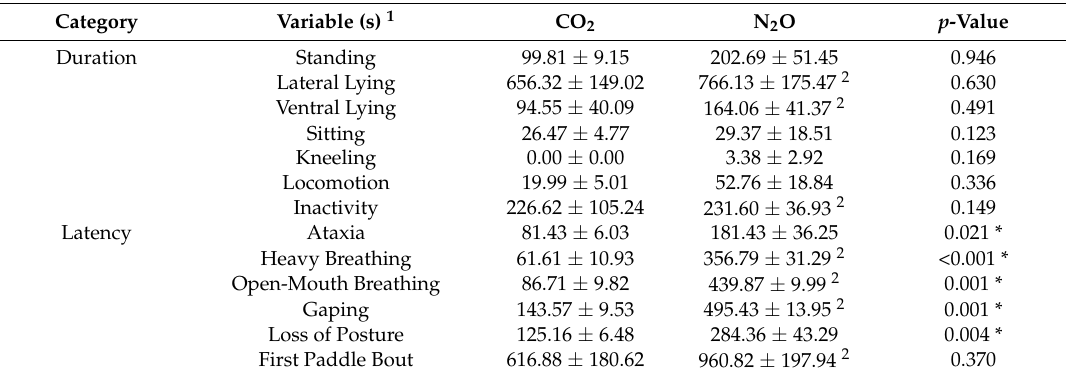
Table 3. Duration and latency data (mean ± SE) on individual piglets during Experiment 1.